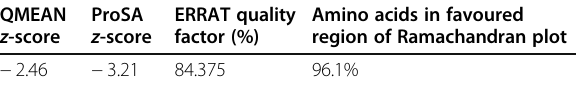
Table 2 Quality assessment scores of 3D modelled structure of